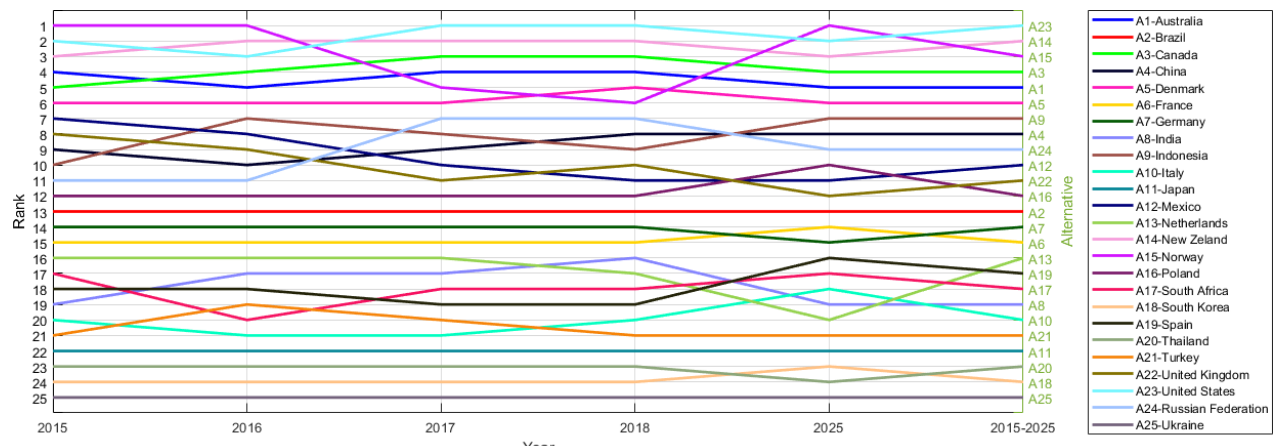
Figure 2. Volatility of SAW rankings in subsequent